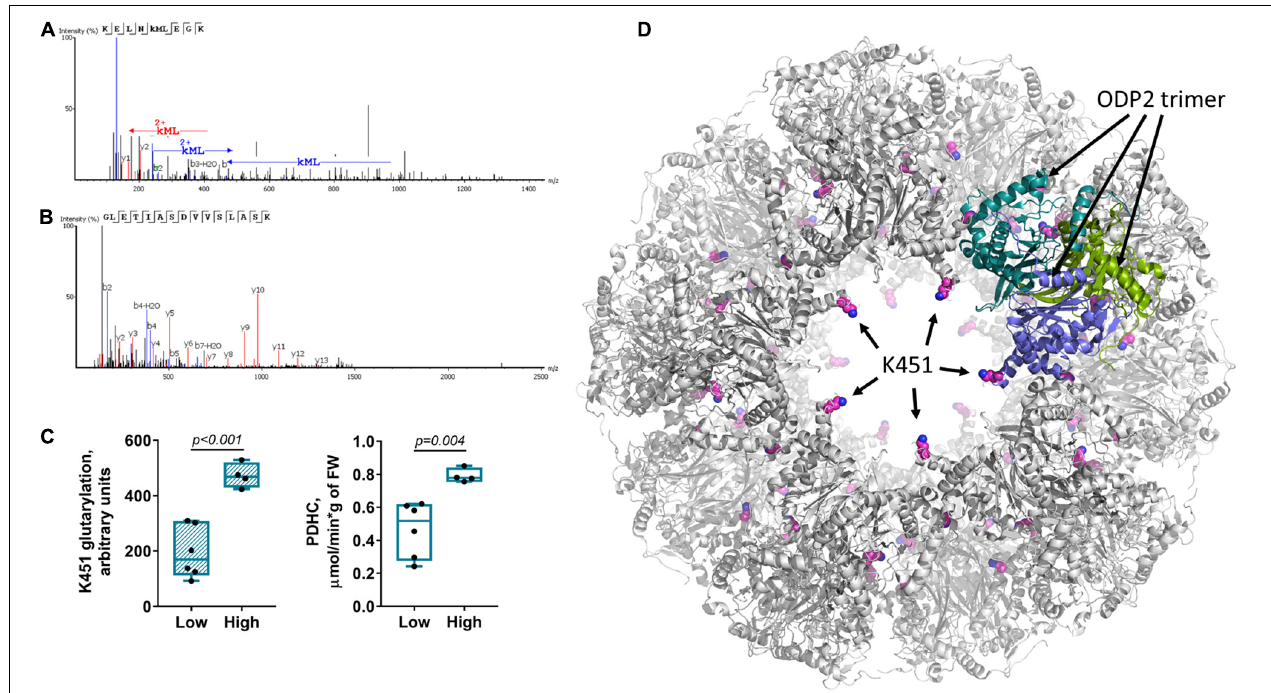
FIGURE 4 | Glutarylation of pyruvate dehydrogenase complex. The glutarylation of lysine K451 of the second component of rat PDHC (ODP2 protein, encoded by DLAT gene) is identified in the rat brain by LC-MS. (A) The spectra of the peptide with K451 glutarylation. (B) The spectra of non-glutarylated peptide, used for normalization. (C) Correspondence of K451 glutarylation of ODP2 to PDHC activity: The six animals with the low K451 glutarylation level also have the low PDHC activity, while the four animals with the high glutarylation level have the high PDHC activity. The animal subgroups exhibit significant differences in the parameters, determined by unpaired Mann-Whitney test and shown as p -values in the graphs. (D) Localization of the glutarylated residue (shown with pink carbon atoms) in the ODP2-formed core of PDHC, according to the structure (PDB: 6CT0) of human protein, whose K466 corresponds to K451 of the rat protein. Subunits of one of the ODP2 trimers, organized by five around the “pore” to the inner cavity of the core, are colored in green, blue and marine. As seen from the structure, K451/K466 residue faces the pore. The residue glutarylation would change electrostatics of the entrance to/exit from the inner cavity of the